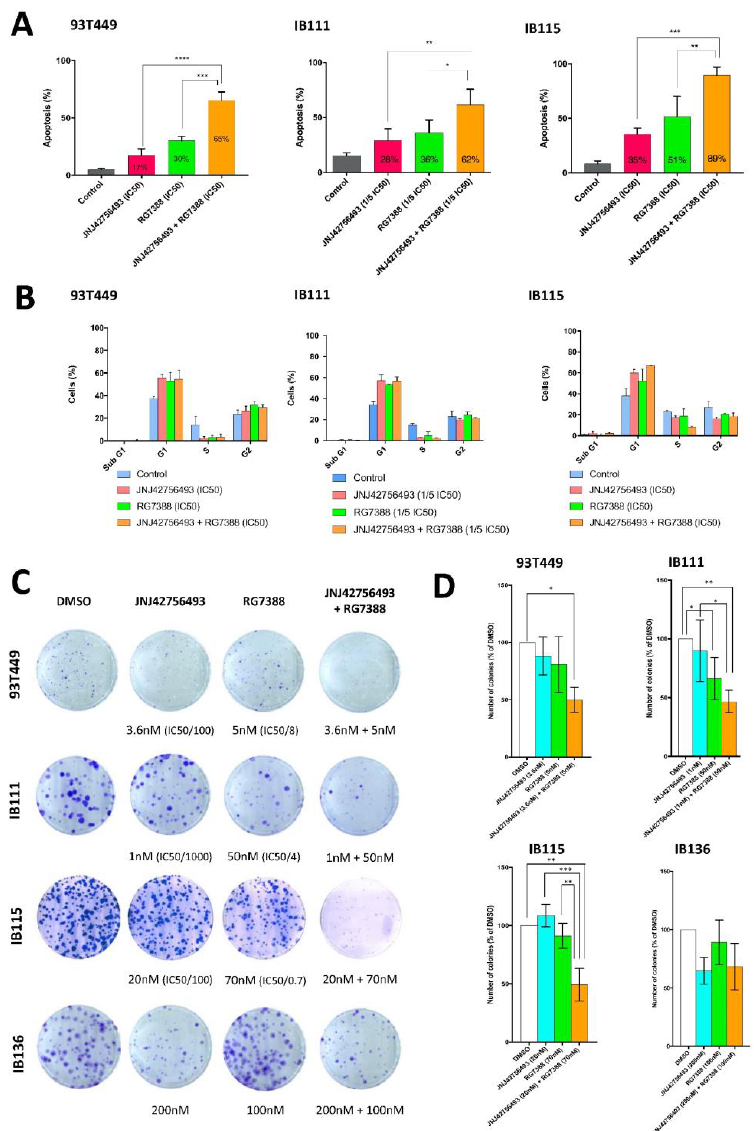
Figure 5. E ff ects of JNJ42756493 and RG7388, as single agents and in combination on in vitro tumorigenicity. ( A ) Effects on apoptosis induction. Quantification of apoptotic cells using annexin V-FITC and propidium iodide staining followed by flow cytometry after 72 h of treatment by JNJ42756493 or RG7388 and in combination (shown in Figure S4A). JNJ42756493 and RG7388 concentrations were determined according to IC 50 values, respectively: 0.36 µ M and 0.04 µ M (93T449), 0.2 µ M and 0.04 µ M (for the IB111 cells, because of a high level of apoptosis, concentrations were decreased to 1 / 5 of IC 50 values for each single agent) and 2 µ M and 0.05 µ M (IB115). ( B ) E ff ects on cell cycle distribution. Quantification of cell cycle analysis (shown in Figure S4B) using propidium iodide incorporation and flow cytometry after 48 h of treatment using the same drug concentrations on the same cell lines as in ( A ). ( C , D ). E ff ects on long-term survival. Clonogenic assays in the WDLPS (93T449) and DDLPS cell lines (IB111, IB115) and in the control soft tissue LMS cell line (IB136), using the indicated JNJ42756493 and RG7388 concentrations. ( C ) Representative pictures of the clonogenic assay. ( D ) Quantification of the number of colonies obtained in the same experimental conditions as in ( C